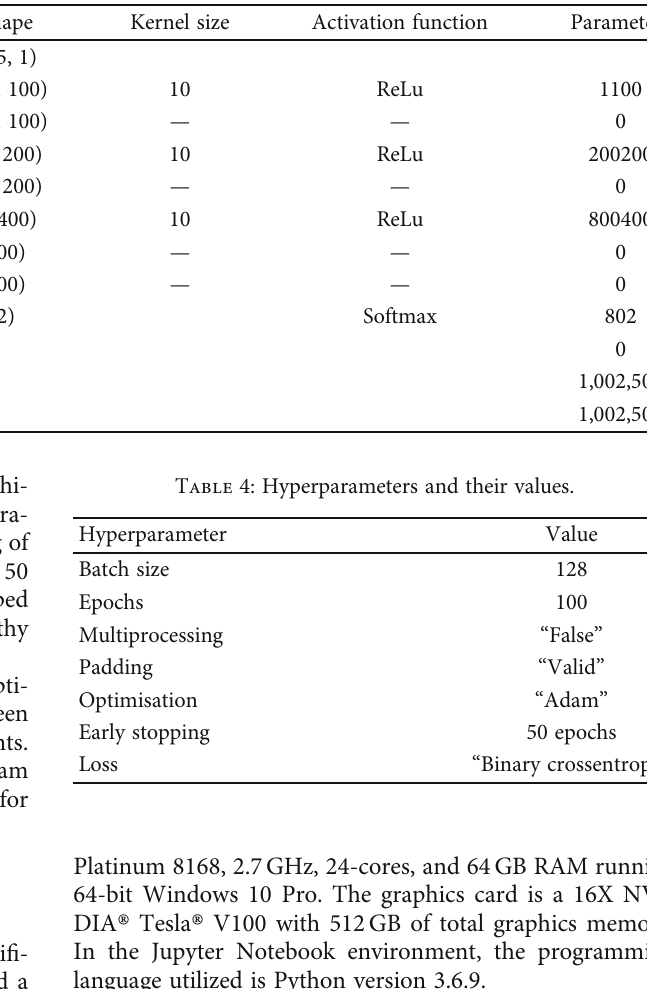
Figure 3: Proposed GatiRec-Net Table 3: A proposed GaitRec-Net model summary with various parameters.